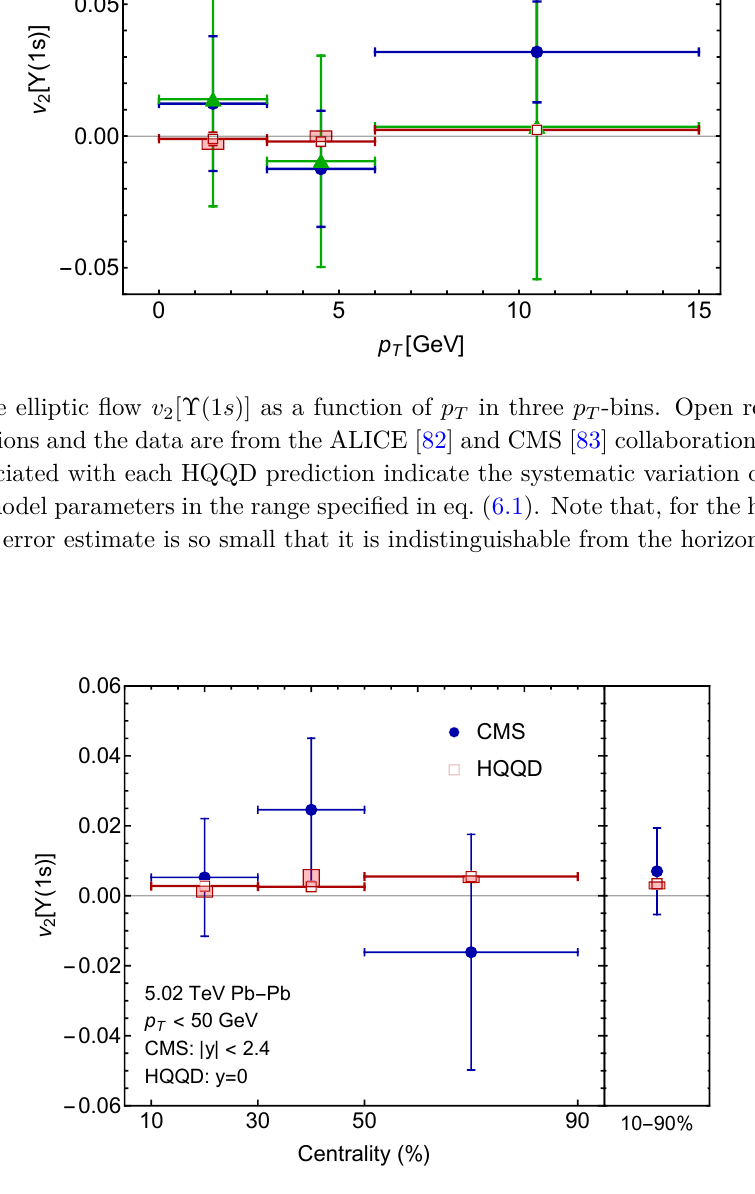
Figure 7 . Centrality dependence of v 2 [Υ(1 s )] shown in 10–30%, 30–50%, 50–90%, and 10–90% centrality bins. Open squares are predictions of HQQD. The shaded red boxes associated with each HQQD prediction indicate the systematic variation observed when changing the model parameters in the range specified in eq.